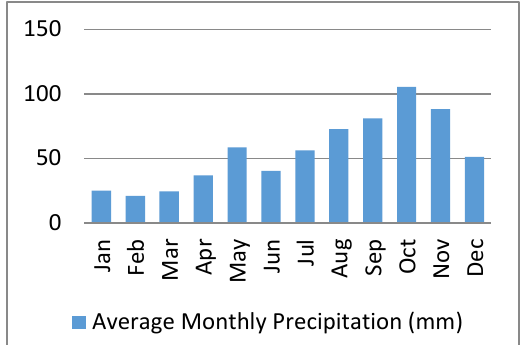
Figure 3 . Average monthly temperatures for Codrington, Barbuda. Source